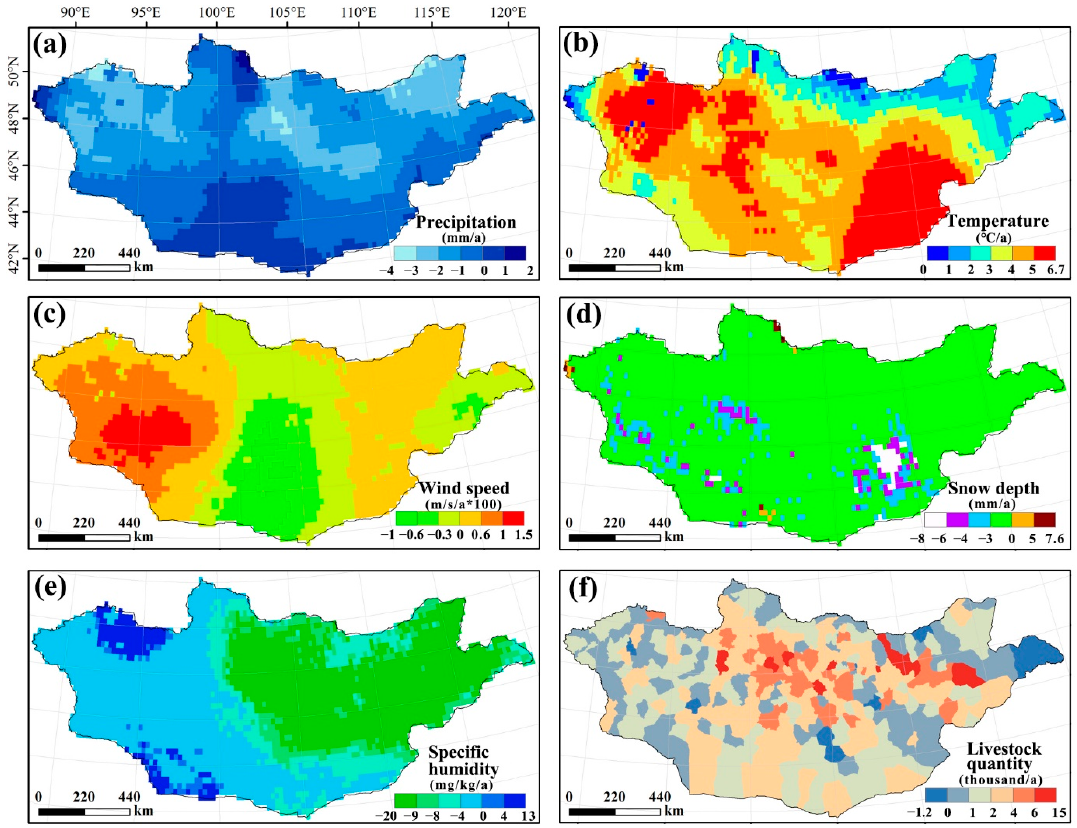
Figure 6. Spatial distributions of climate factors and livestock quantity from 1982 to 2015: ( a ) precipitation, ( b ) temperature, ( c ) wind speed, ( d ) snow depth, ( e ) specific humidity, and ( f ) livestock quantity.